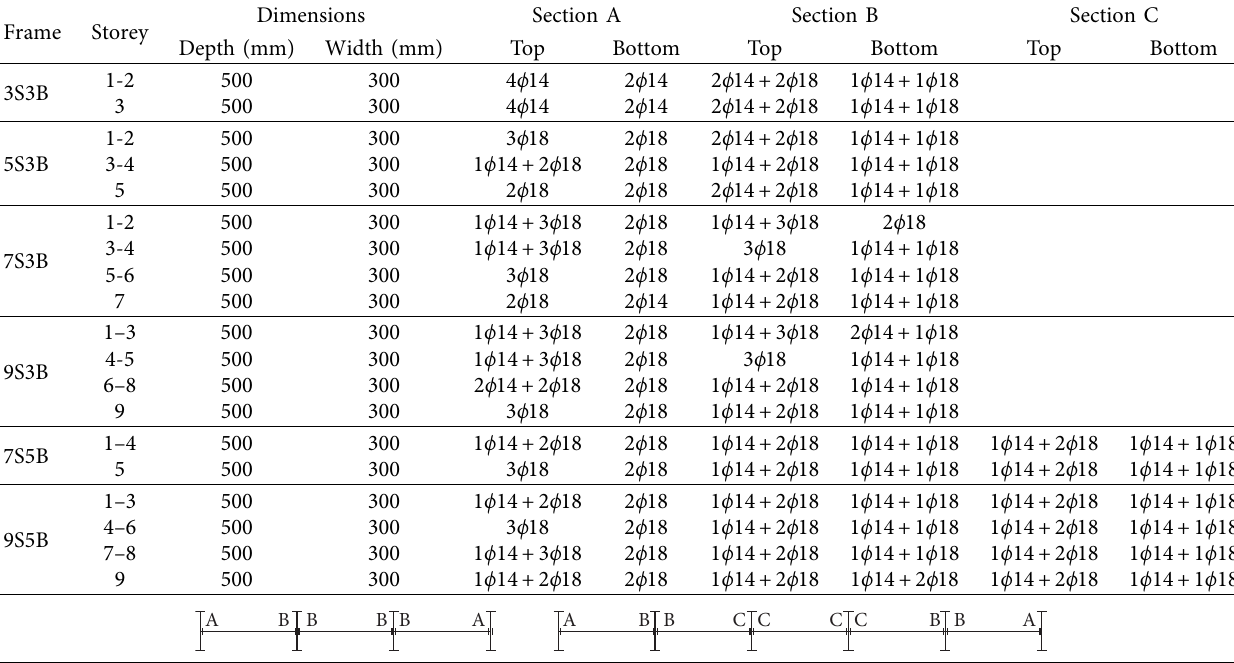
Table 2: Beam dimensions and reinforcement